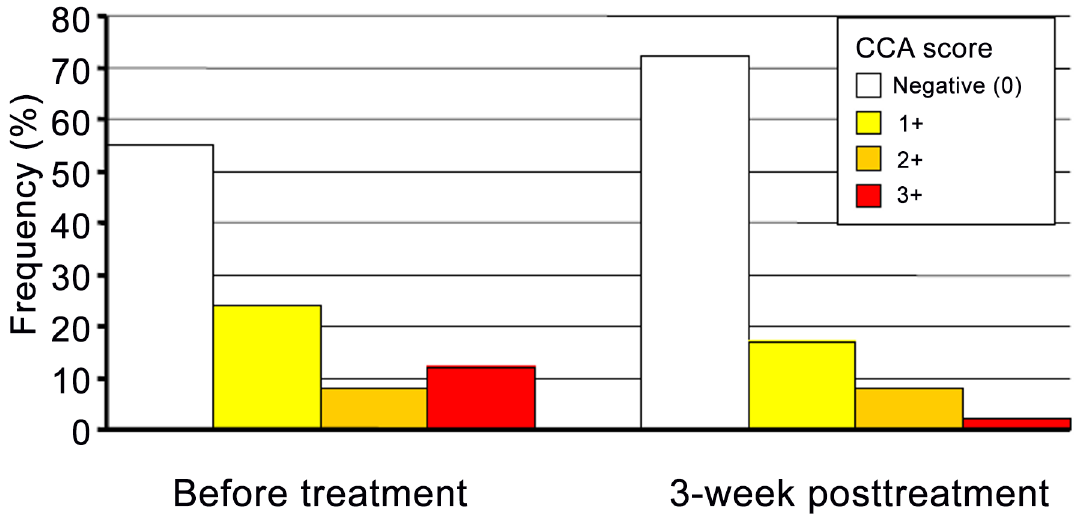
Figure 3. Frequency of CCA test scores before ( n =242) and after praziquantel administration ( n =86). The frequency of the CCA test scores (0, 1 + , 2 + , and 3 + ) before and after treatment with praziquantel was determined based on combined scores from days 1 and 2, as show in Table 1. Note that trace results were considered as negative.